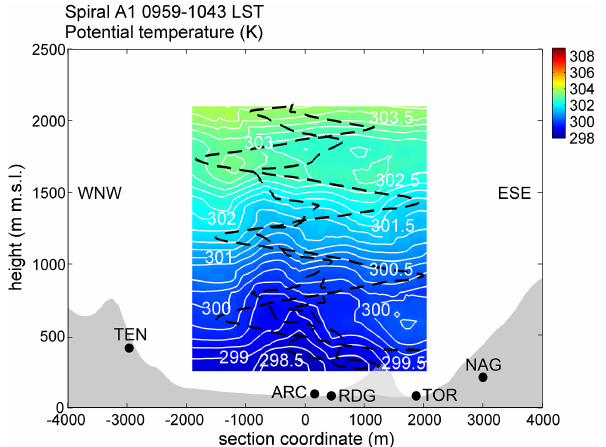
Figure 7. Cross-valley vertical section of RK-interpolated θ field for spiral A1. The contour interval is 0.25K (in white). The grey shading indicates the valley topography. The horizontal coordinate marks the cross-valley direction. The cross section (along-valley co- ordinate: 1000m; cf. Fig. 8) is taken immediately N of Mt. Brione (whose profile is shown by the semi-transparent grey shading). The black dashed line is the projection of the motorglider’s trajectory over the considered section. The projection of the position of RDG, TOR, NAG, TEN and ARC is also indicated (black dots). No- tice that the RK-estimated standard deviation of the interpolated θ values (i.e. the square root of the RK-estimated variance of the predicted θ residuals; see Goovaerts, 1997) varies between 0.00K (close to the trajectory) and 0.25K (at the farthest points from the trajectory) over the fields displayed in Figs. 7–10 and 12.